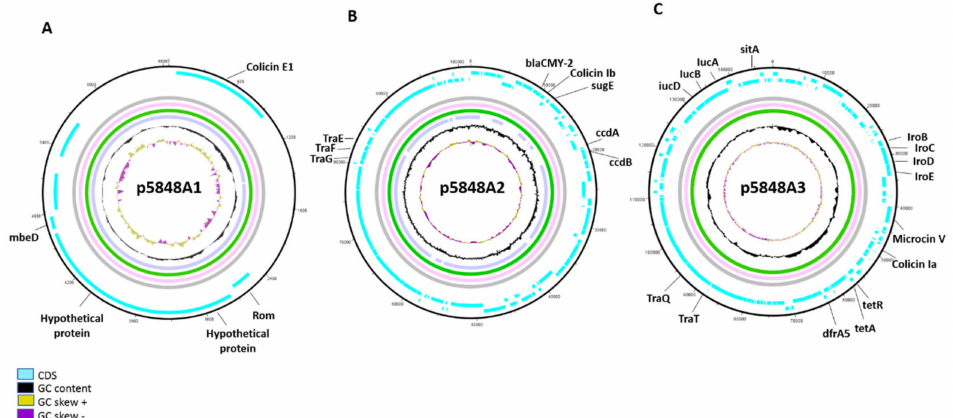
Figure 3. ST131 plasmid sequence alignments using hybrid assemblies. ( A ) Sequence alignment of plasmid p5848A1 found in isolates 5332, 5848 and 7078 containing the colicin E1 gene. ( B ) Alignment of plasmid p5848A2 found in isolates 7078, 5332 and 5848, containing the beta-lactamase bla CMY-2 , the sugE and the colicin Ib genes. ( C ) Alignment of plasmid p5848A3 found in isolates 5332 and 5848, containing the colicin Ia and microcin V genes, the resistance genes dfrA5 , tetA and tetR and the virulence genes iucA, sitA, iroB, iroC, iroD and iroE. Isolate 5332 is indicated in pink, 5848 in green and 7078 in light purple. In addition, blue indicates the coding sequence region (CDS), black indicates the GC content, yellow indicates regions with a positive GC skew, and dark purple yellow indicates regions with a negative GC